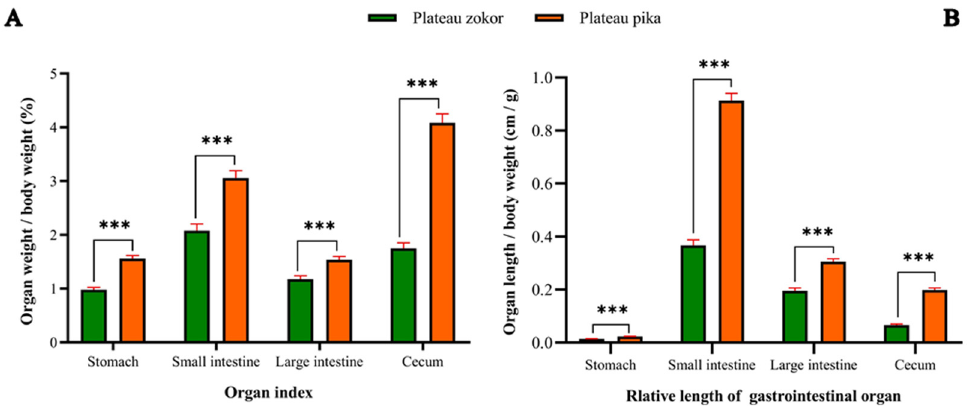
Figure 5. Differences in gastrointestinal organ index and relative length between the plateau zokor and plateau pika. ( A ) Differences in gastrointestinal organ index between the plateau zokor and plateau pika. ( B ) Differences in relative length between the plateau zokor and plateau pika. *** indicates an extremely significant difference ( p < 0.001). Table 1. Differences in gross GIT between the plateau zokor and plateau pika.